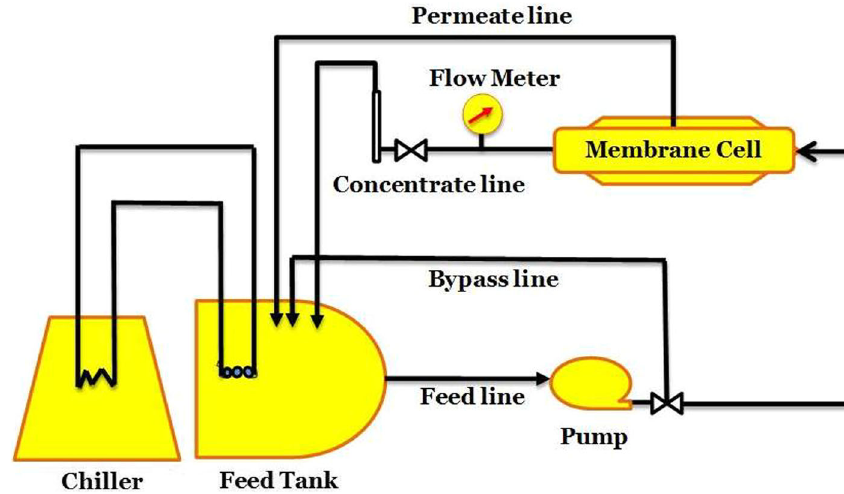
Fig. 1 Schematic illustration